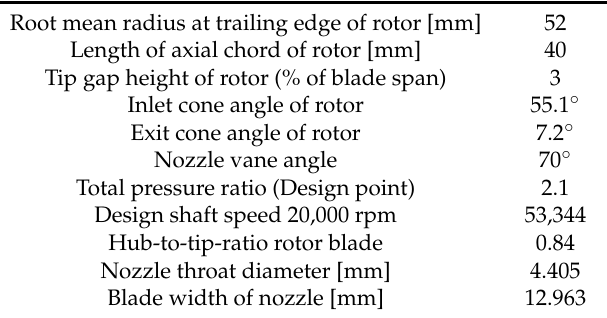
Table 1. Turbine geometry parameters.